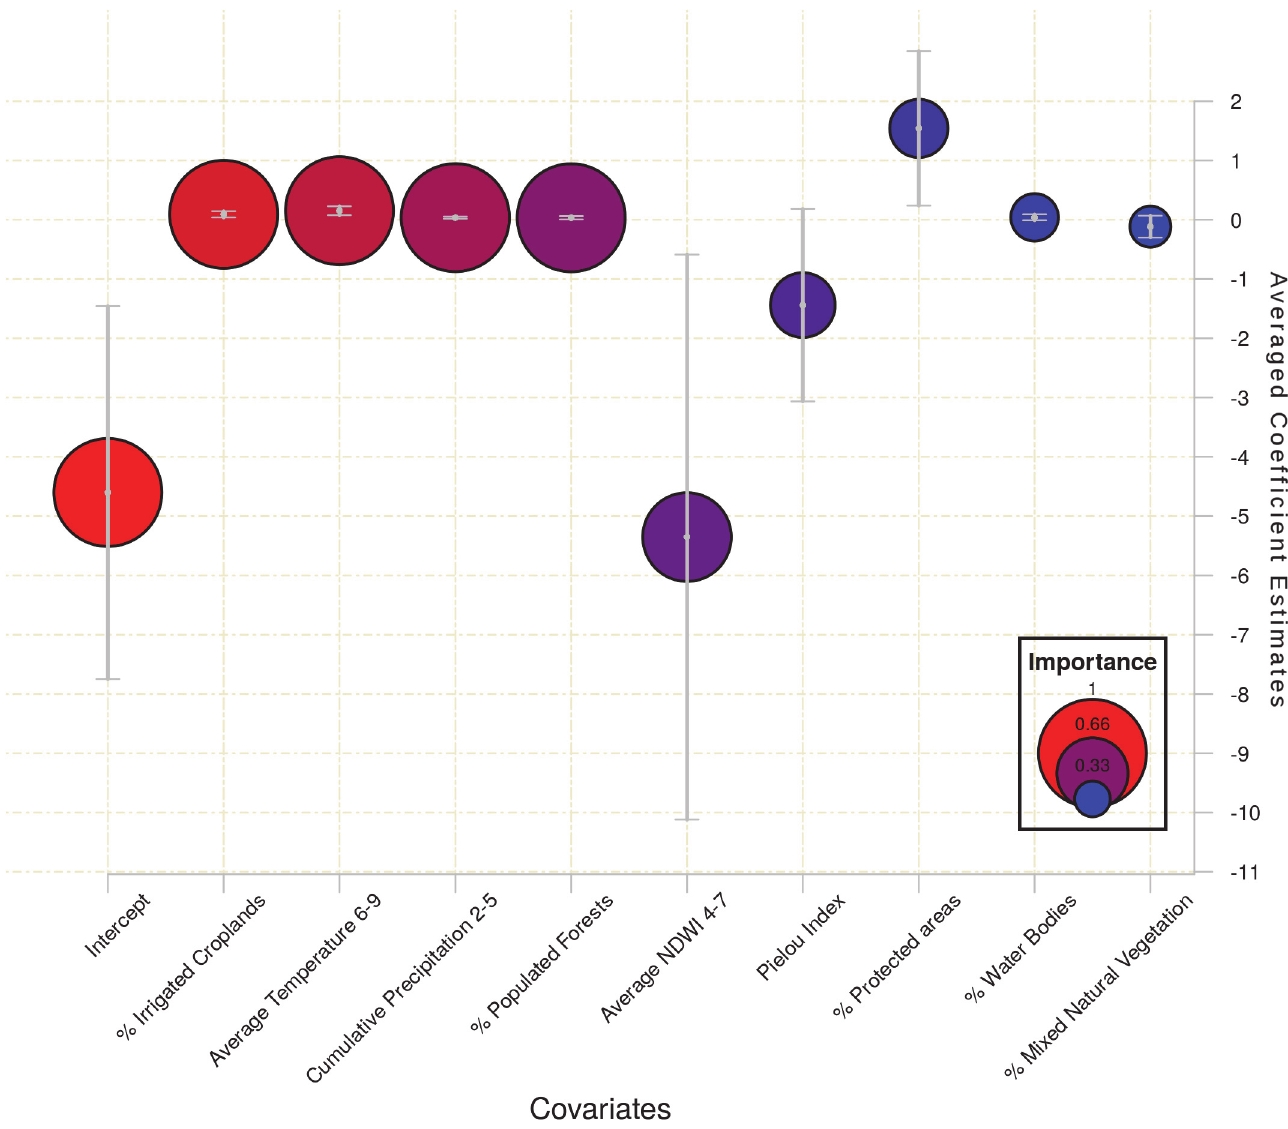
Fig 3. Summary statistics from the best 9 models ( Δ AIC (cid:1) 2 from the best model) for log-transformed WNF incidence (from 2010 to 2012). The coefficients have been derived using multi-model averaging. The model term ‘ Importance ’ is proportional to the number of times that the variable is included in the set of best models and is represented by the colour and size of the bubbles (red/bigger bubble = high importance; blue/smaller bubble = low importance). Where referred to in the figure, each variable (Temp, PrecTot, PrecDays, NDVI, NDWI) is prefixed with Ano. or Av. for standardised anomaly or average, and the relevant period denoted in subscript (e.g. Ano.Temp 2 – 5 = weekly anomaly temperature during months 2 –